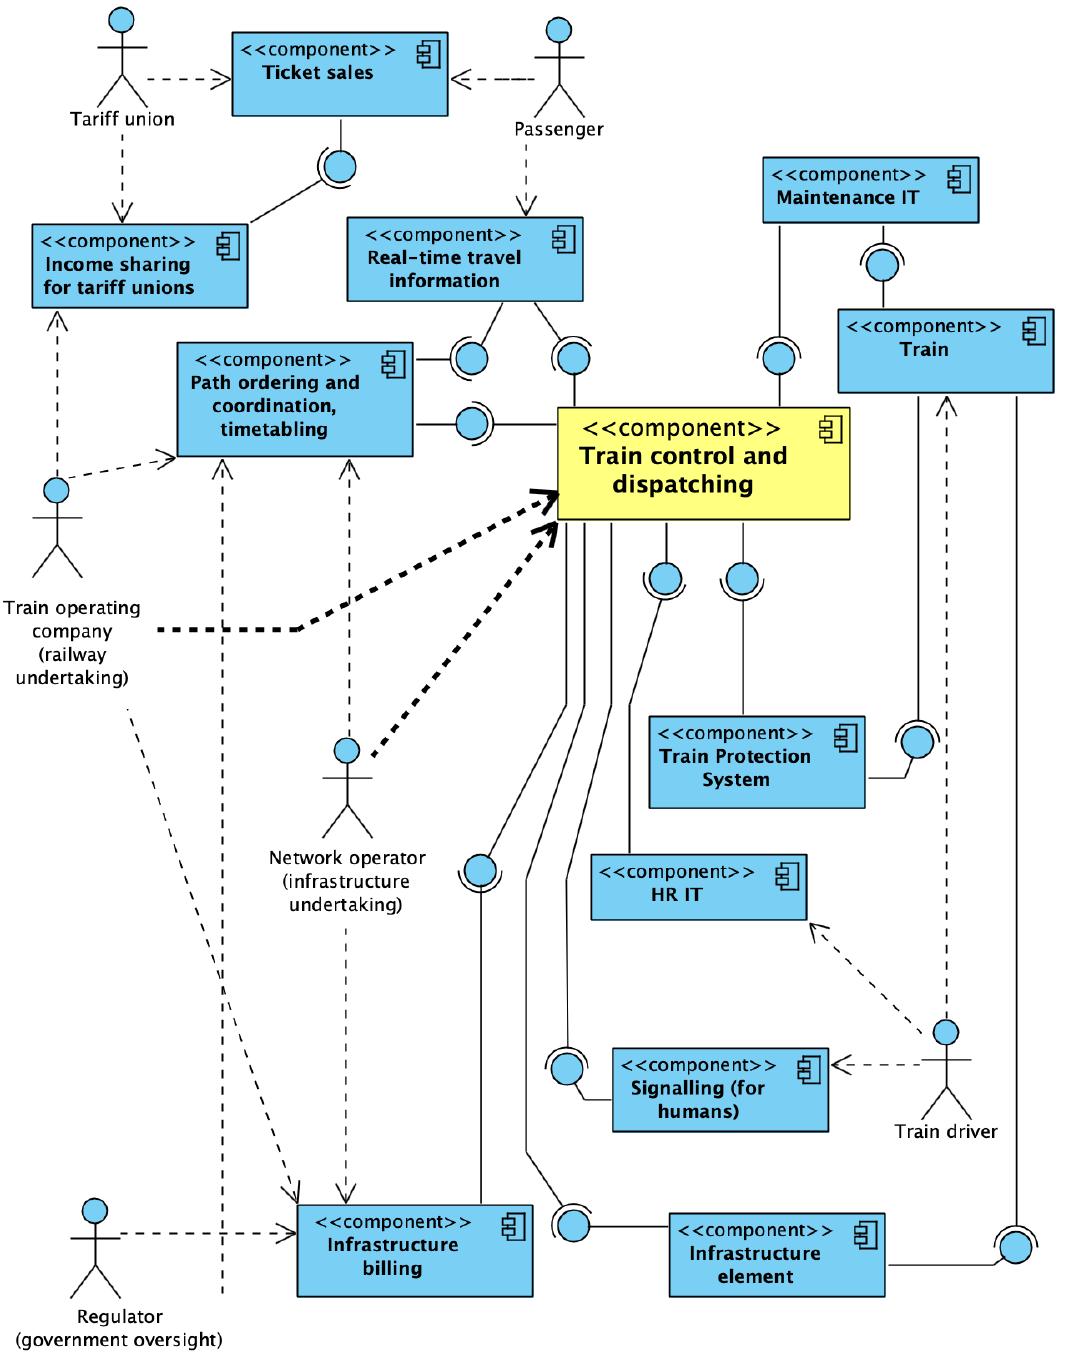
Fig. 1. Train control and dispatching IT with adjacent IT systems and